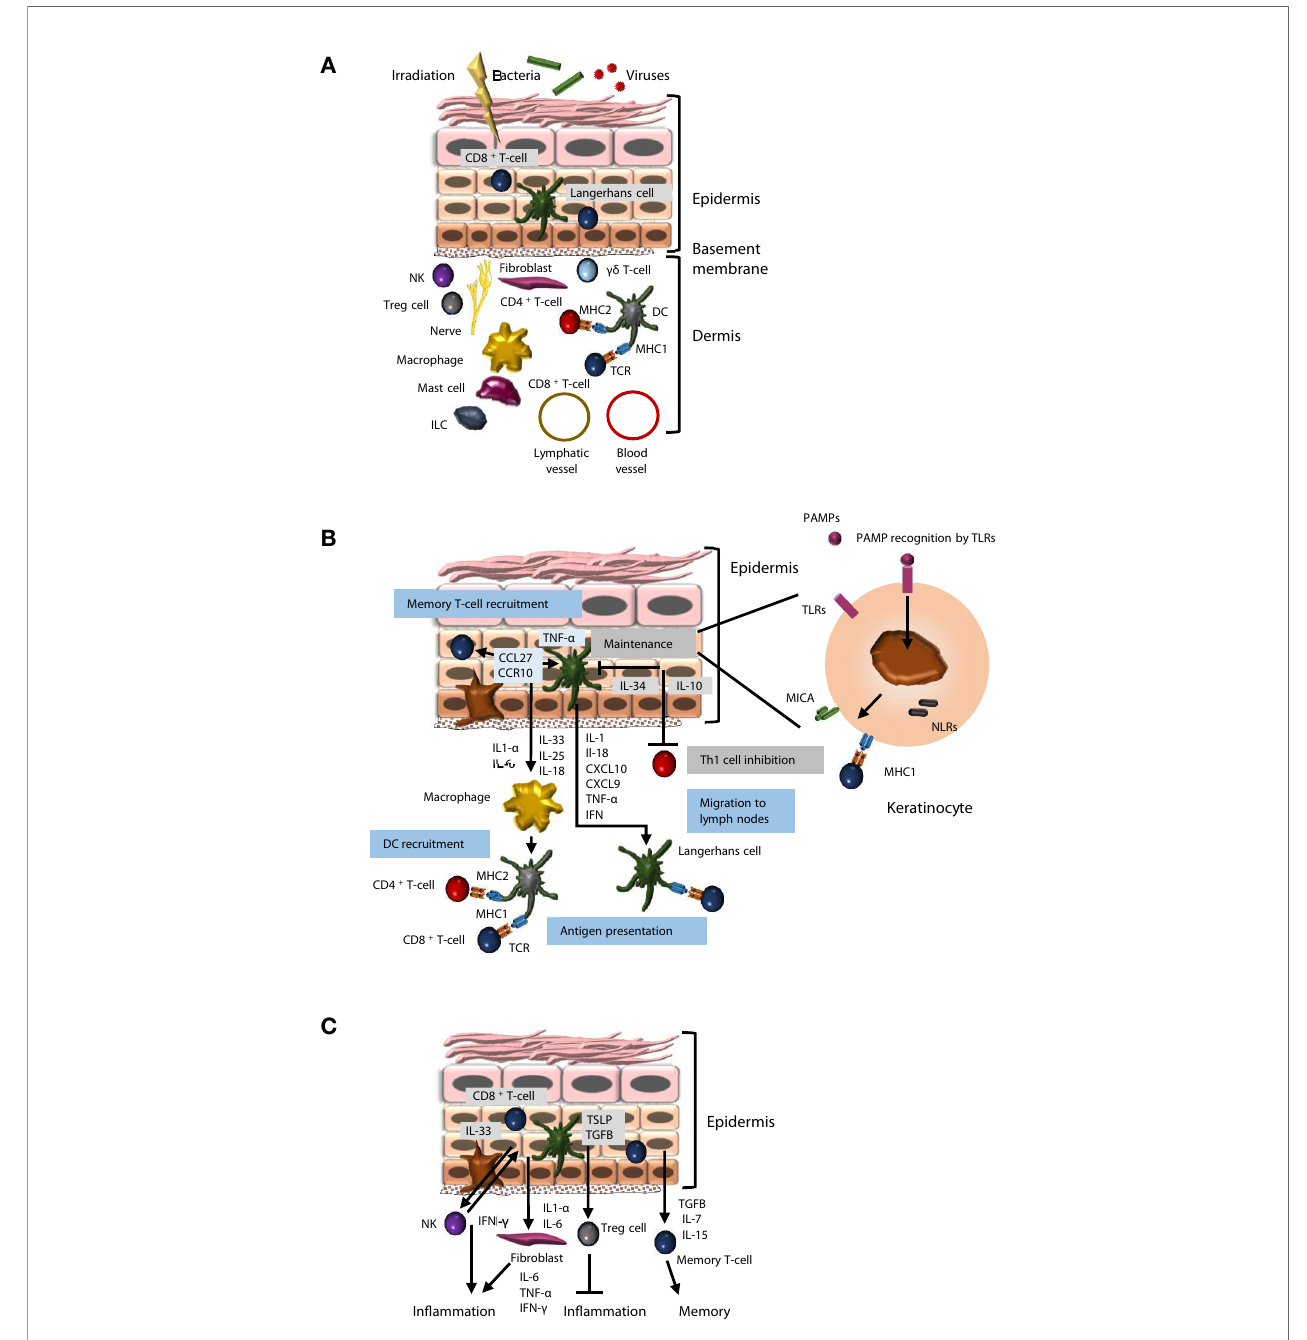
FIGURE 1 | Immune properties of skin keratinocytes. (A) Cellular components of the skin immune system. The skin is a barrier that protects against injury, pathogens, chemicals and radiation. The local immune system includes resident immune cells and cells recruited from the periphery. The epidermis hosts effector cells, such as CD8 + T-cells and Langerhans cells that migrate to lymph nodes to perform antigen presentation. In the dermis, Treg cells, NK, CD4 + T-cells, mast cells, ILCs, macrophages and dendritic cells participate in immune activities. In addition, resident non-hematopoietic skin cells have immune functions, which are not fully elucidated. (B) Keratinocyte interactions with immune cells. Keratinocytes recognize pathogen-associated molecular patterns (PAMPSs) through TLR and NLR receptors and stimulate the recruitment of resident memory T-cells, dendritic cells and circulating T-cells through pro-in fl ammatory cytokine secretion. On the other hand, they are also able to promote tissue homeostasis through anti-in fl ammatory cytokine secretion (IL-34, IL-10). (C) Keratinocytes participate in the regulation of in fl ammation and the maintenance of skin immune memory. Keratinocytes promote in fl ammation through IL-1, IL-3 and IL-6 secretion, but also limit it through TSLP and TGFB secretion. Keratinocytes can promote the maintenance of immune memory through various mechanisms, including TGFB, IL-7 and IL-15